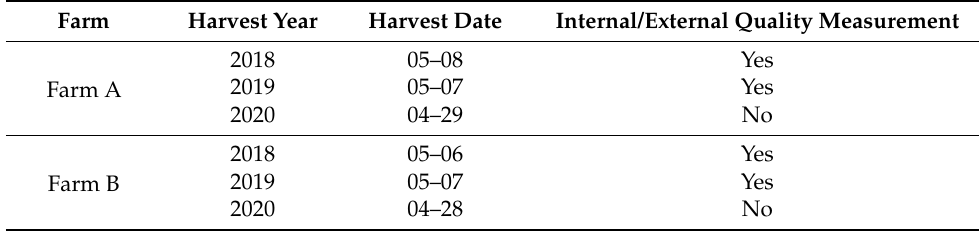
Table 3. Potato harvest years, date and tuber yield, internal and external quality measurements.